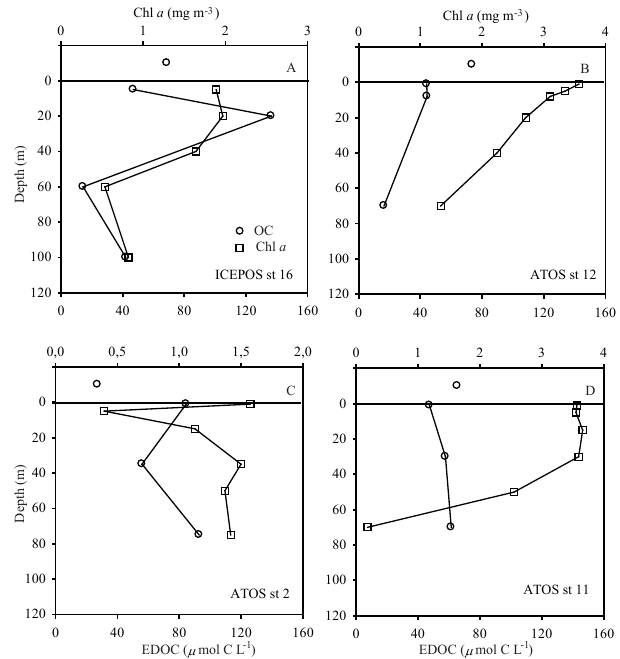
Figure 9. Representative depth profiles of EDOC and Chl a . Example profile performed during ICEPOS (A) . During ATOS- Antarctica, 9 followed Chl a (B) , 10 showed no clear pattern (C) and 3 were opposite to Chl a (D) . Open circles refer to organic car- bon (OC) measured as EDOC in the water and as GOC H 0− 1 (single open circle) in the atmosphere. Open squares refer to Chl a